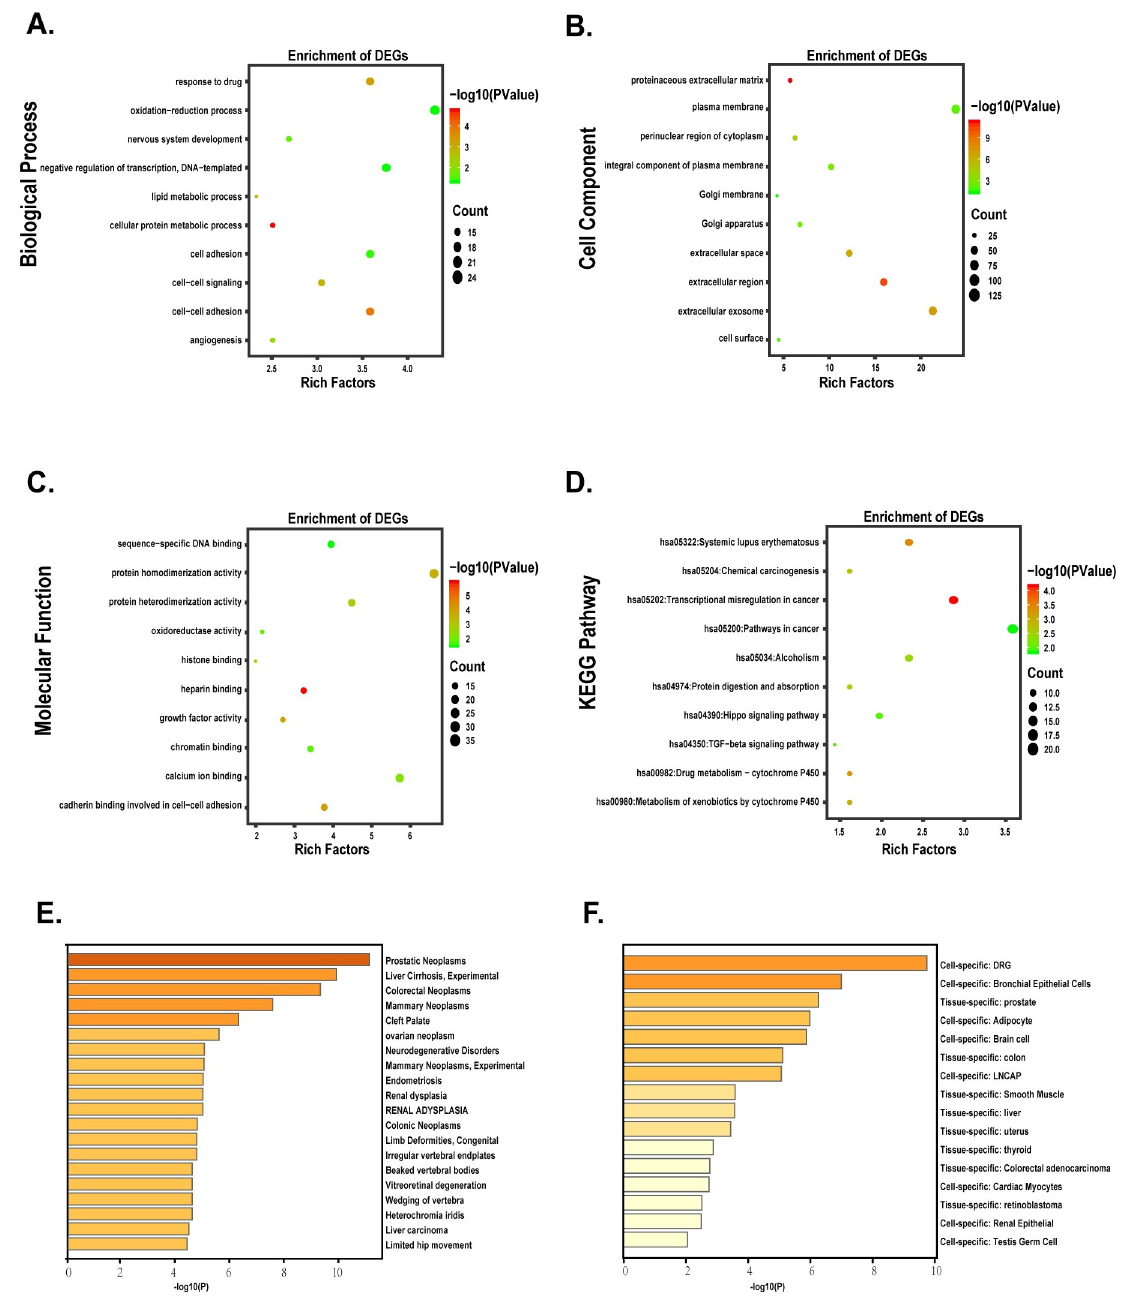
Fig 2. Functional analysis of DEGs. (A-D) The bubble plots indicated the results of function enrichment analysis in DEGs. (A) Biological process. (B) Cell component. (C) Molecular function. (D) KEGG pathways. (E-F) Different expression genes enriched in the specific tissues and cell